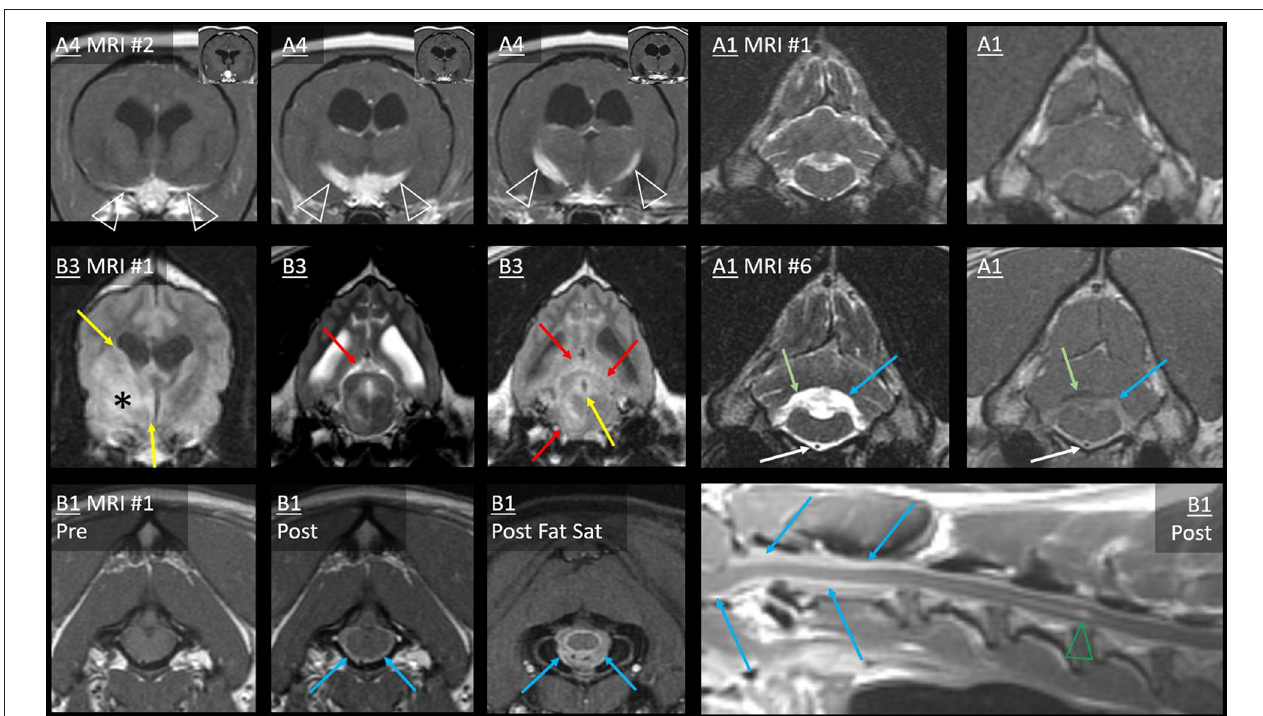
FIGURE 6 | Type 1b dissemination: Diffuse leptomeningeal lesions. Case A4: post-radiation transverse T1W post-contrast images (level of the optic chiasm and tracts). A contrast-enhancing mass effaces the chiasma. Thin, strong leptomeningeal contrast enhancement extends over both ventral cortical surfaces (arrowheads, first image). Very thick leptomeningeal enhancement follows the optic tracts dorso-caudo-laterally (arrowheads, second and third images). Bilateral ventriculomegaly is present. Inset: pre-radiation images—the primary mass is present without any leptomeningeal lesion. Case A1: transverse T2W and T1W post-contrast images from before (MRI #1) and after surgery (MRI #6) for a parietal mass. On MRI #6, thick and strong leptomeningeal contrast enhancement and T2-hyperintensity have developed ventral to the medulla (white arrows), encasing the basilar artery. Additionally, the height of the T2-hyperintense fourth ventricle and contrast-enhancing choroid plexus has considerably increased (blue arrows). There are T2-hyperintensity and T1-hypointensity in the cerebellum dorsal to the enhancement (green arrows). In Case B3, transverse FLAIR (level of the third ventricle) and T2W and FLAIR (level of caudal aqueduct) images show the primary mass (asterisk). Periventricular FLAIR-hyperintensity (yellow arrows) affects the lateral and third ventricles and the periaqueductal GM (PAG). On the T2W image, there is poor distinction between aqueductal CSF and PAG. Midbrain SAS has a normal appearance on T2W, but CSF is markedly FLAIR-hyperintense (red arrows). Neoplastic cells were present in subependymal (ventricles and PAG) and subarachnoid (including midbrain) sites at necropsy. T1-weighted images of Case B1: transverse at the level of the foramen magnum (pre- and post-contrast), the atlanto-occipital joint (post-contrast with fat saturation), and post-contrast mid-sagittal cervical. There is diffuse cervical leptomeningeal enhancement extending from caudal medulla oblongata (blue arrows). On fat saturation image, thick leptomeningeal enhancement surrounds bifurcating ventral spinal artery and spinal cord. Central canal ependymal enhancement crescendos at C4–C5 (green